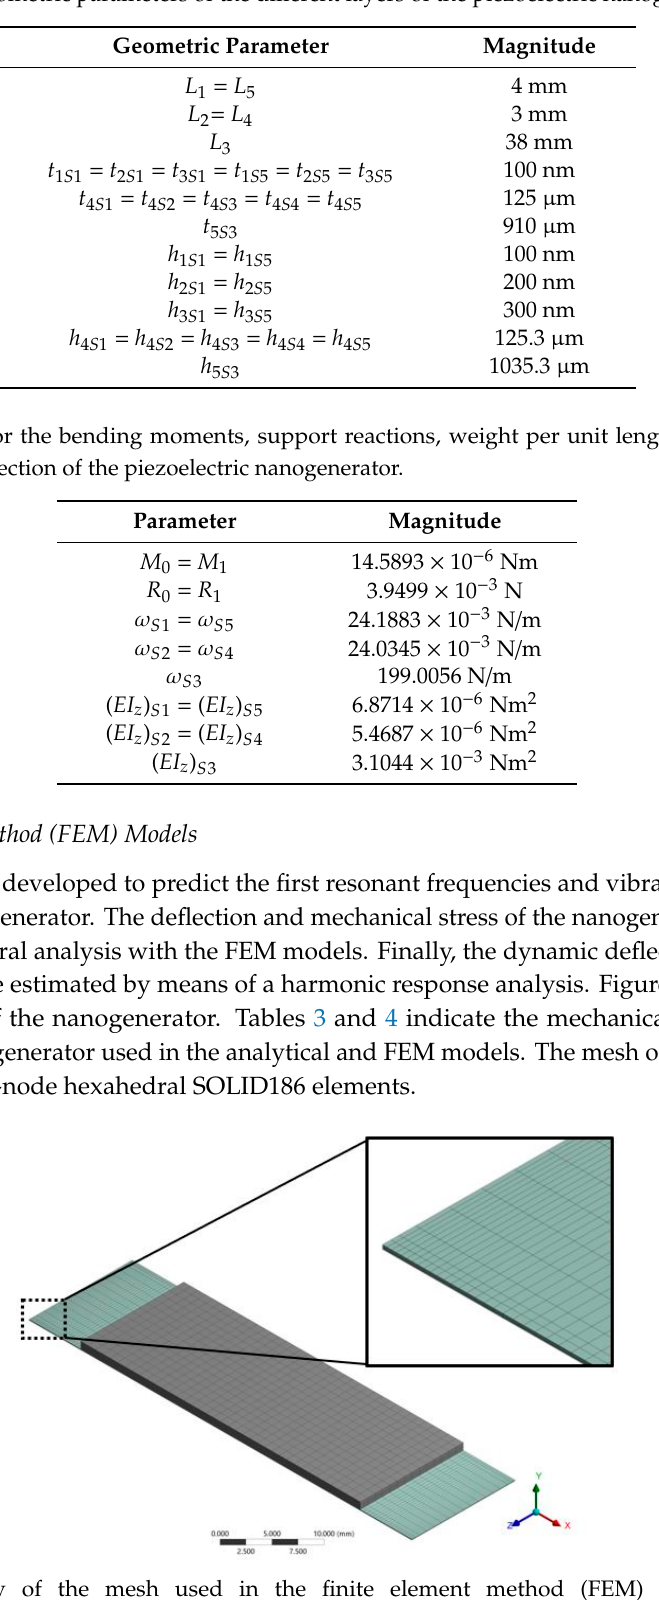
Table 1. Geometric parameters of the di ff erent layers of the piezoelectric nanogenerator.